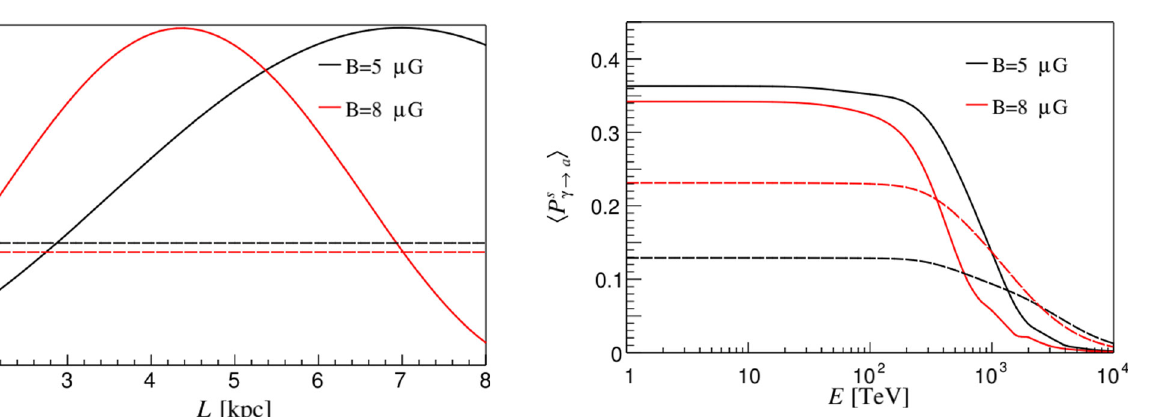
Fig. 4 Photon-ALP conversion probability in the host-galaxy as a function of the source size L for the case of a regular field, for E = 10 TeV, g a γ = 3 × 10 − 11 GeV − 1 and z = 0. We consider two values of the magnetic field: B T = 8 × 10 − 6 G (red curves) and B T = 5 × 10 − 6 G (black curves). The continuous curves represent the probability P s γ → a ( L ) , while the dashed ones represent the average (cid:15) P s (cid:16) γ → a